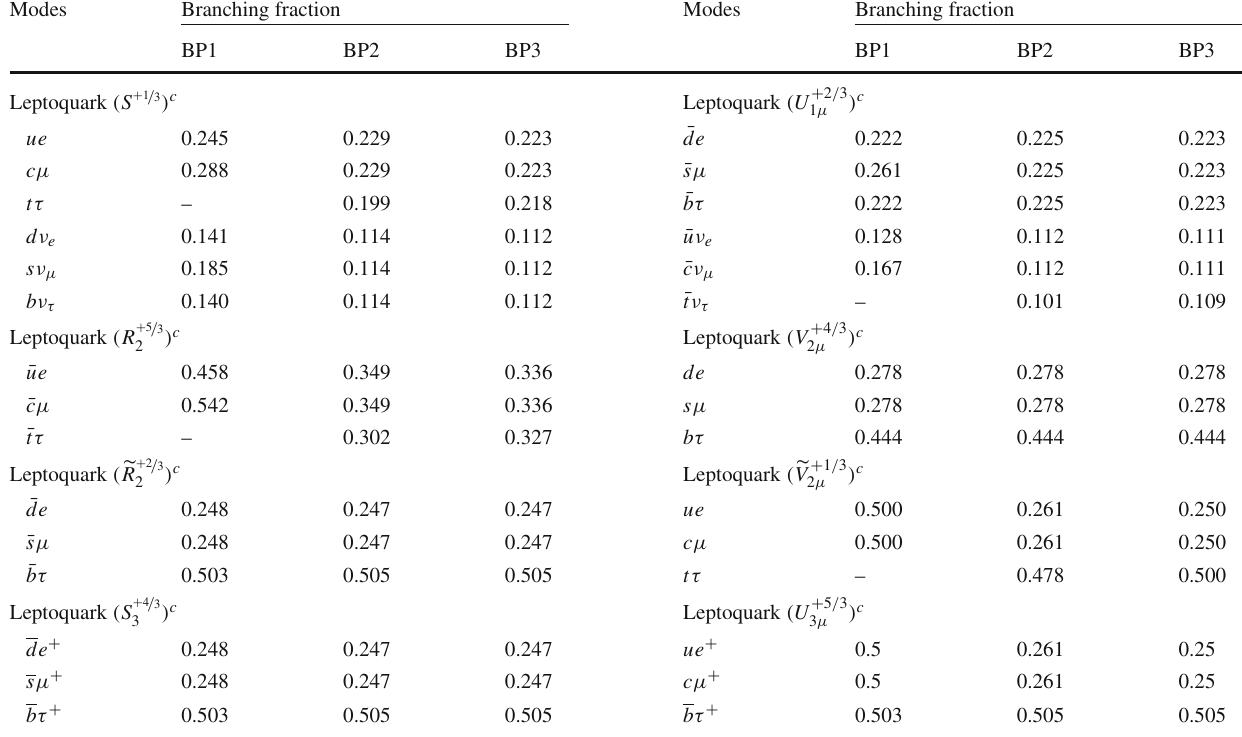
Table 4 Branching fractions of the leptoquarks for the given benchmark